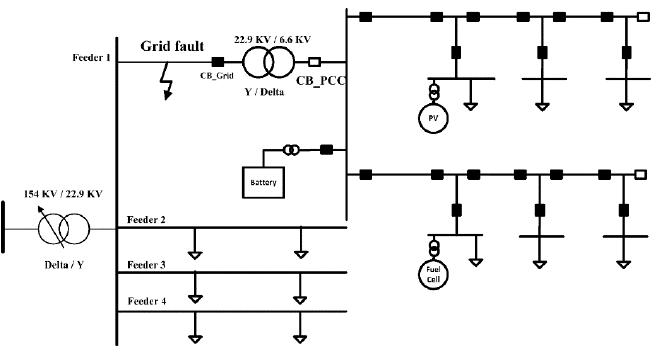
Figure 7. Utility grid single line-to-ground (SLG) faults.